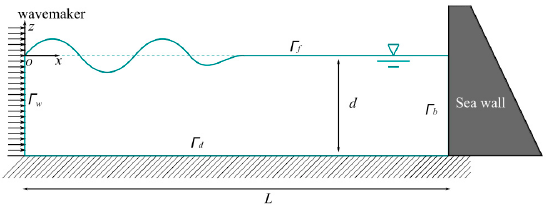
Figure 1. Sketch of the wave flume.